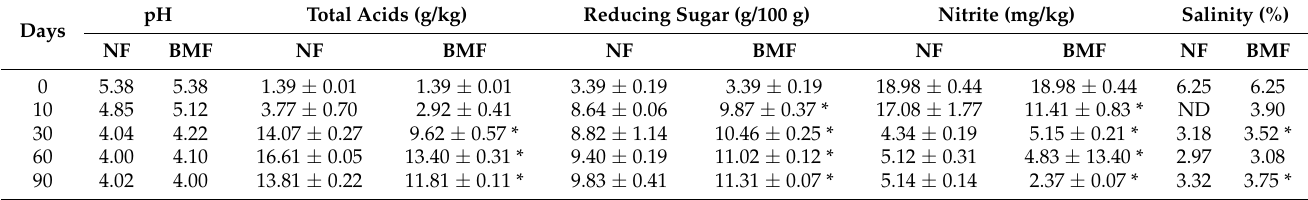
Table 1. The physicochemical characteristics of NF and BMF at different fermentation